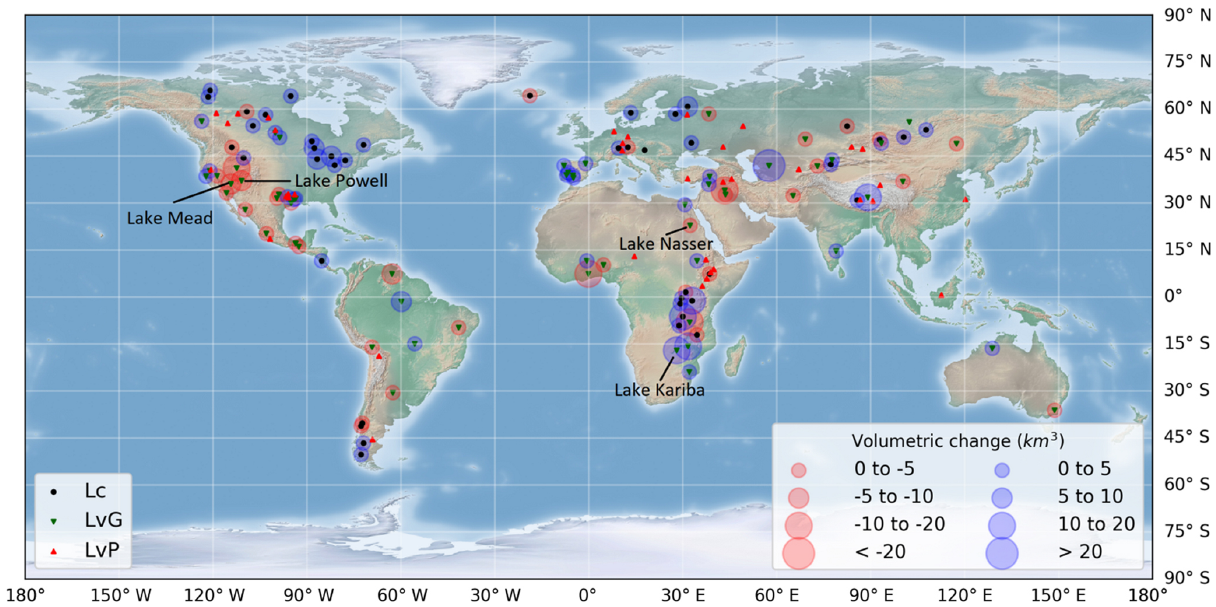
Figure 7. Lake and reservoir types (constant area (Lc), variable area with good (LvG) and poor (LvP) regression performance) with the average volume